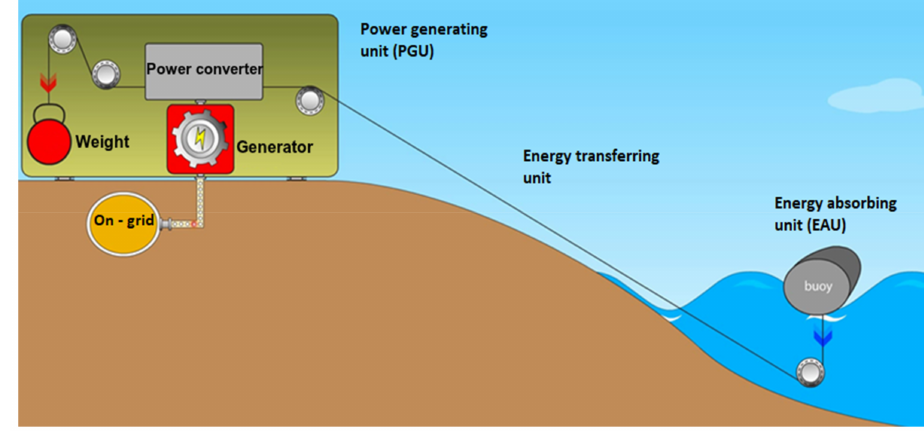
Figure 1. Schematic diagram of nearshore WEC configuration [13].